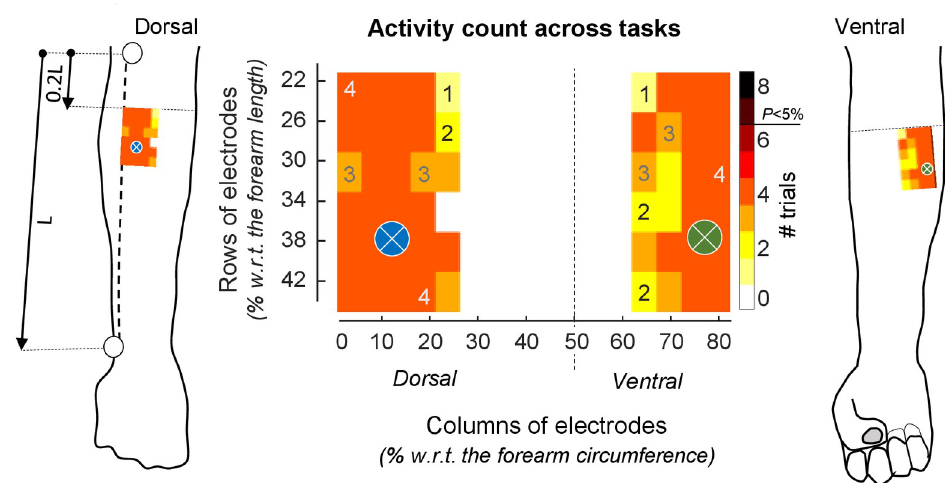
Fig 5. Number of over-significance-threshold EMGs across trials. Image showing the counts of pixels, across trials, providing pseudo t values which average was greater than the statistical threshold. Maximal count is eight, considering four classical excerpts and the four octaves performed at preferred speed. Counts are schematically represented with respect to anatomical references. Counts greater than 6 would indicate a significant consistency across trials. The exact same distribution of counts was obtained when considering octaves performed at high speeds. Regions where pairs of bipolar electrodes are recommended to be centered for assessing excitation of extensor (blue crossed circle) and flexor (green crossed circle) muscles are